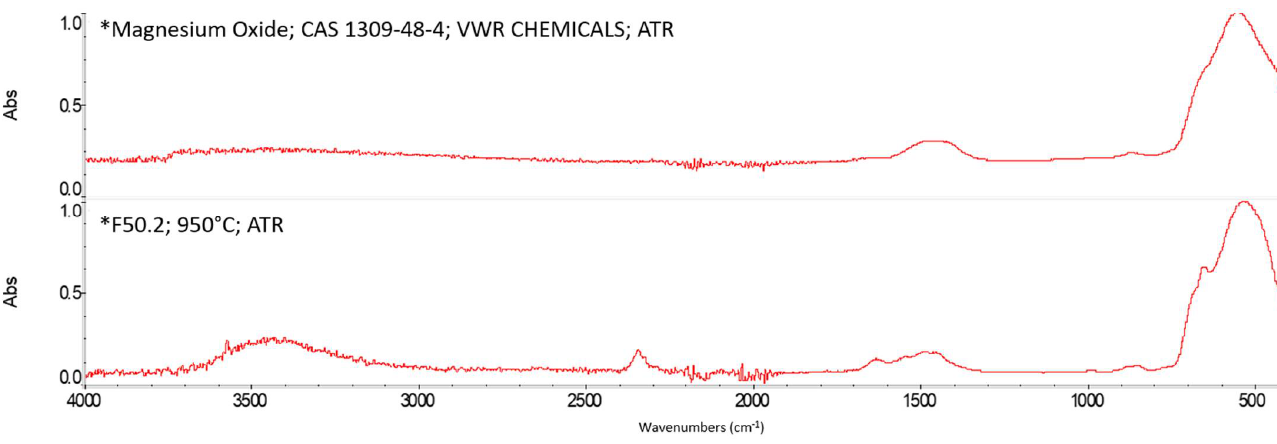
Figure A9. FTIR spectra: MgO versus ashes of F50.2 at 950 °C.